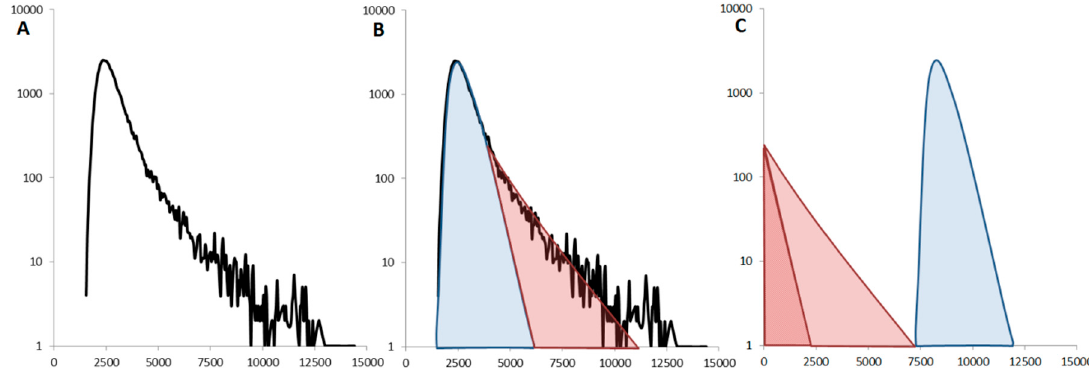
Figure 7. Influence of the large rare aggregates: ( A ) The experimental data obtained for α -synuclein E46K-GFP show an asymmetric distribution of fluorescence values ( B ). The distribution of intensity values can be decomposed into a Gaussian contribution (in blue) and a tail distribution (in red). These two components can then be analyzed separately ( C ). The Gaussian distribution (blue) is analyzed by brightness analysis to give the oligomeric status of the majority of the protein (here monomeric). The tail distribution (red) only contains a small number of events, comparable to data obtained with “pure” (pM) single-molecule acquisition. This can therefore be analyzed using the theory of Photon Counting Histograms (PCH) to give the average number of proteins in the large aggregates.